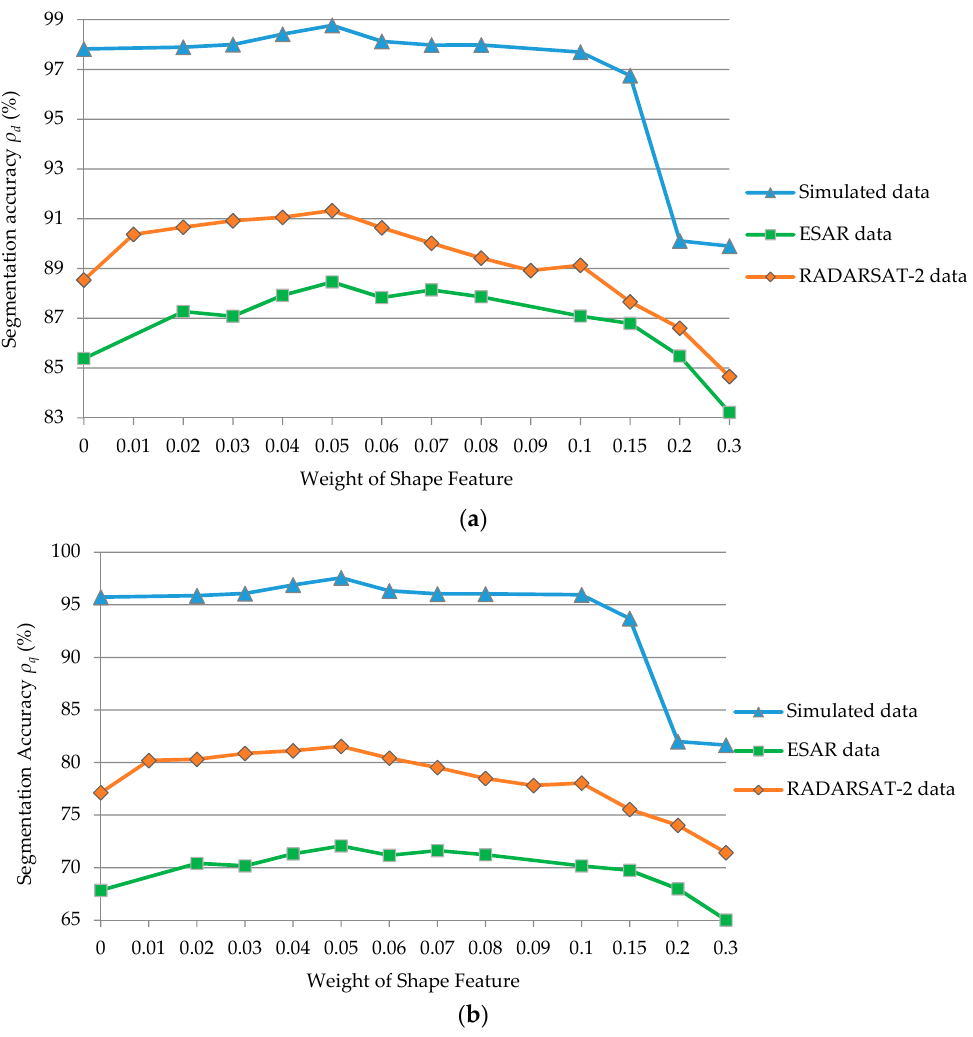
Figure 13. Segmentation accuracy obtained using the IFGS method for the simulated data, ESAR, and RADARSAT-2 data with different shape weights: ( a ) detection rate; ( b ) quality rate.